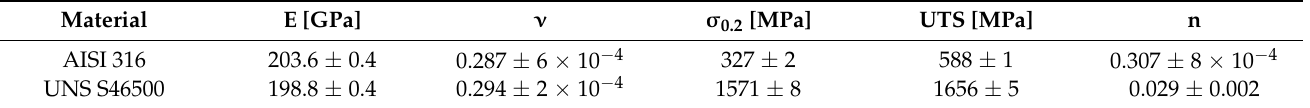
Table 4. Mechanical properties of the AISI 316 and UNS S46500 stainless